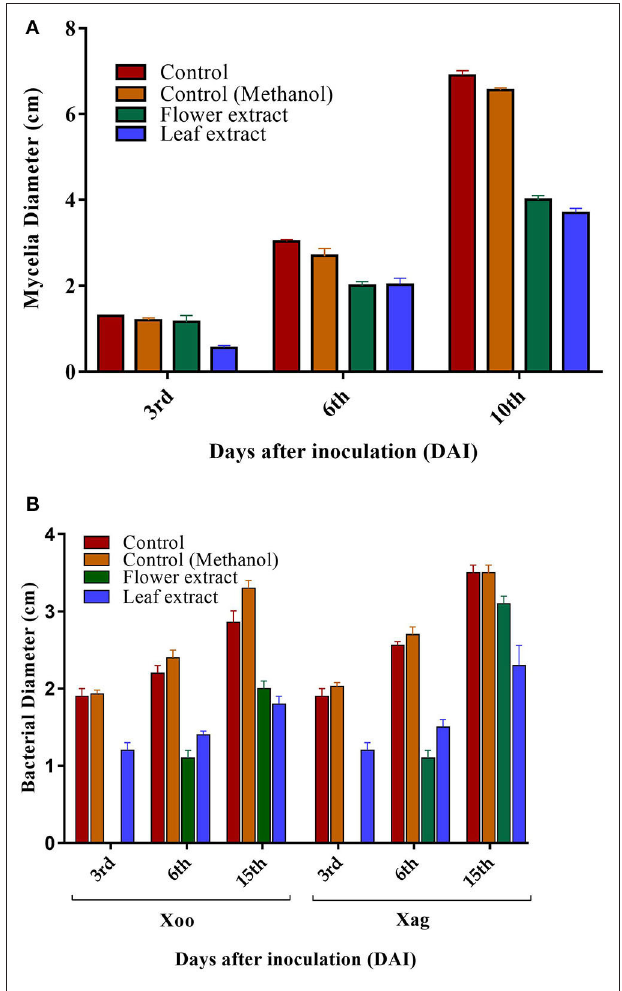
FIGURE 4 | Antimicrobial activities of L. camara FE and LE. (A) Antifungal activity of FE and LE against M. oryzae after 3, 6, and 10 days of inoculation. (B) Antibacterial activity of FE and LE against Xoo and Xag of Xanthomonas after 3, 9, and 15 days of inoculation. Values represented as mean ± SD ( n = 3, P <